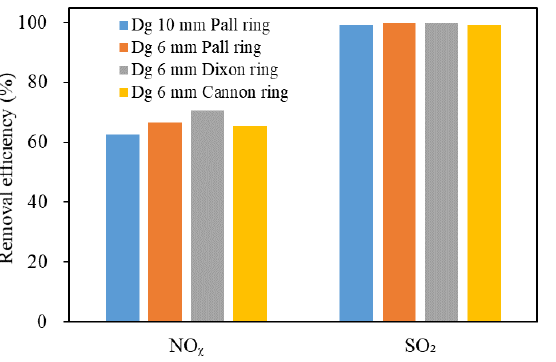
Figure 5. Desulfurization and denitration efficiencies of various packing types (operating conditions: gas flow rate = 5 L/min, scrubbing solution = 1% NaOH solution, spray density = 7.6 m (cid:2871) /(m (cid:2870) ∙ h) , packing height = 80 cm).